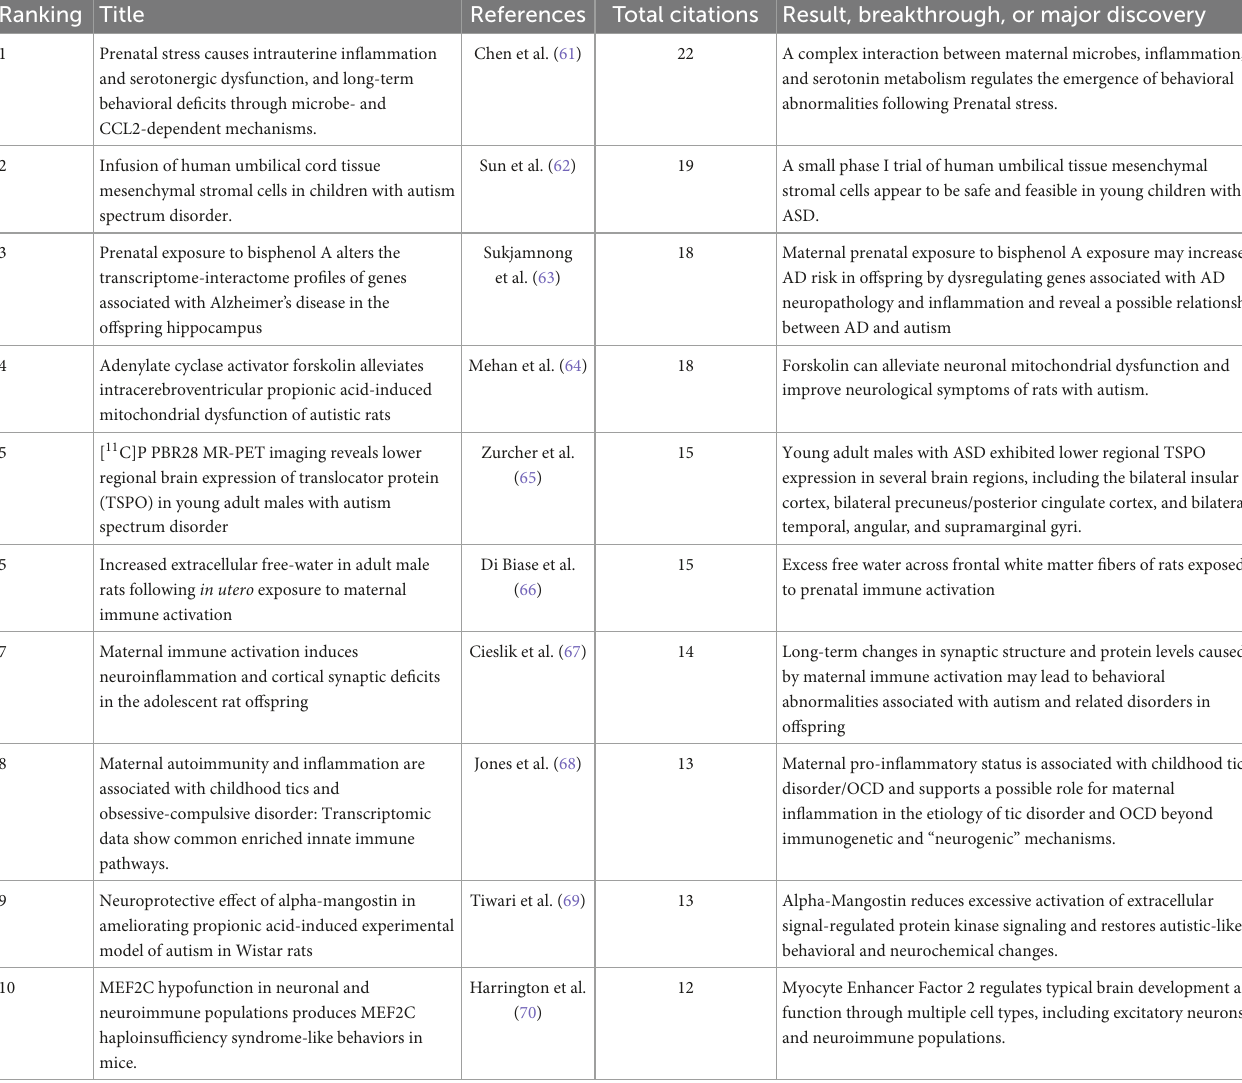
TABLE 5 The basic information of the most cited 10 experimental papers in the last 2